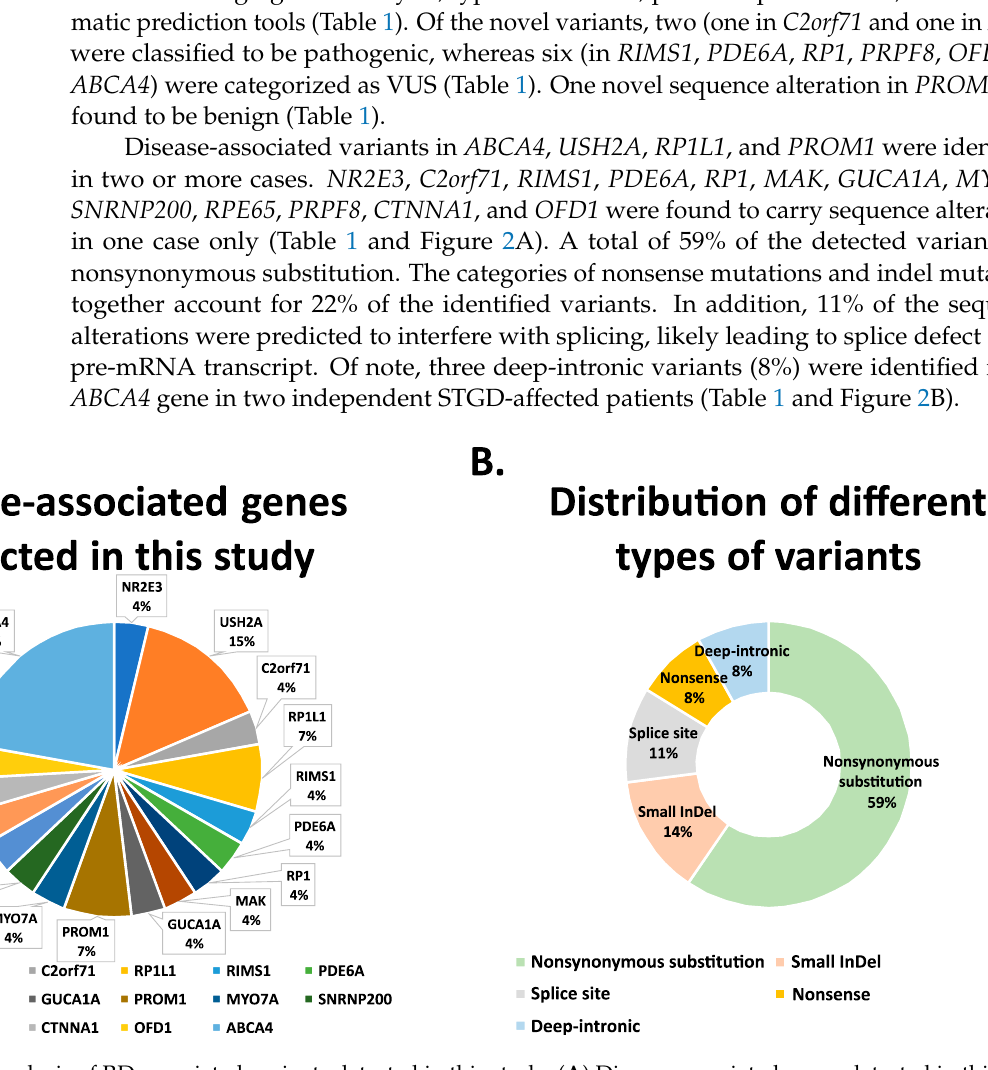
Figure 2. Statistical analysis of RD-associated variants detected in this study. ( A ) Disease-associated genes detected in this study. In total, 17 different genes were detected in 26 RD-affected patients. Disease associated genes are color coded. ( B ) Distribution of different types of sequence variants in known RD-associated genes. Among 37 sequenced variants, 59% nonsynonymous substitution was found, followed by 14% small InDel variants, 11% Splice variants, 8% nonsense variants, and 8% deep-intronic variants.